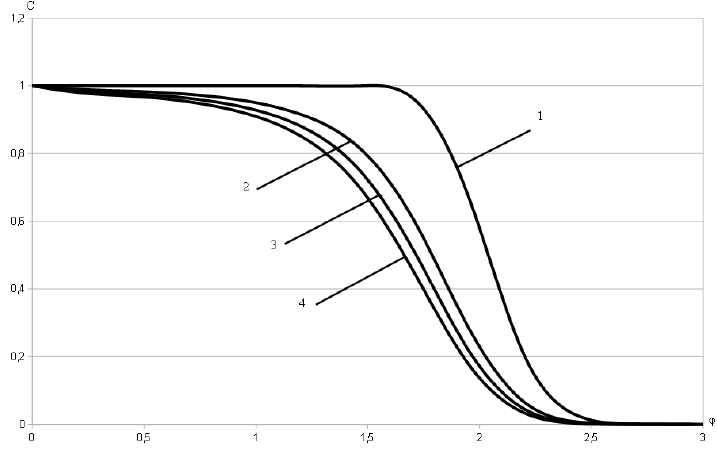
Figure 3. Concentration field along the streamline ψ = 0.5 for t = 5 and a fixed α =